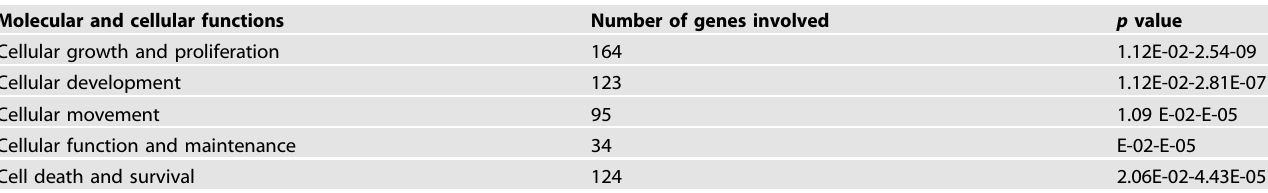
Table 4. Top fi ve MCFs as predicted by IPA for 500 μ M ASA treatment ( p < 0.05). Molecular and cellular